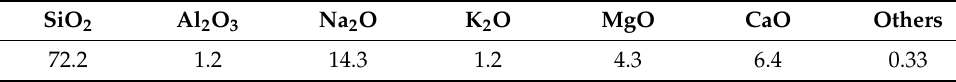
Table 1. Composition of “Menzel” glass in wt.% of oxides. SiO